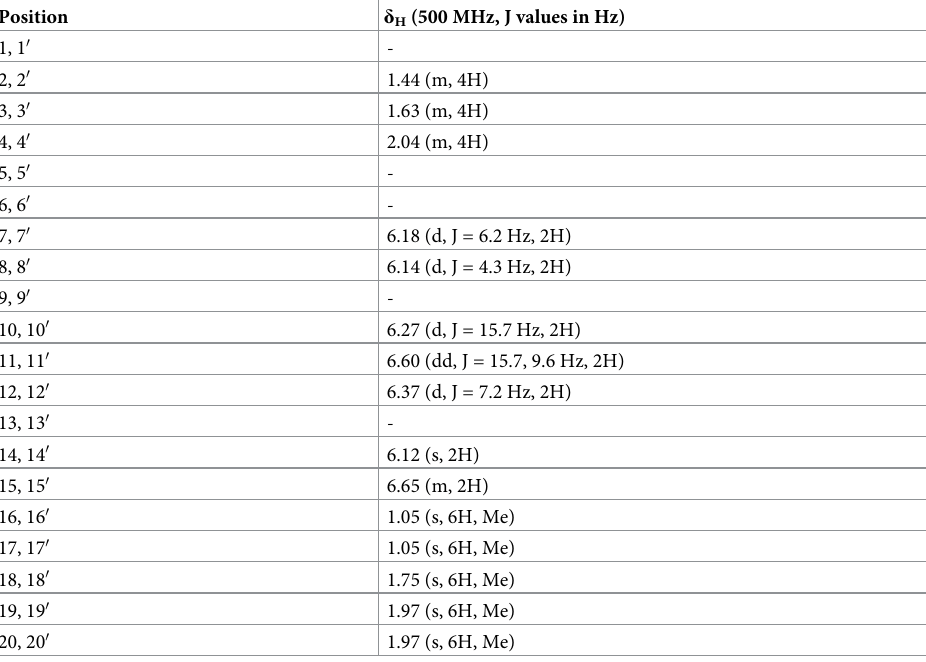
Table 1. The 1 H- NMR spectroscopic data of β -carotene isolated from S . obliquus microalgae. Position δ H (500 MHz, J values in